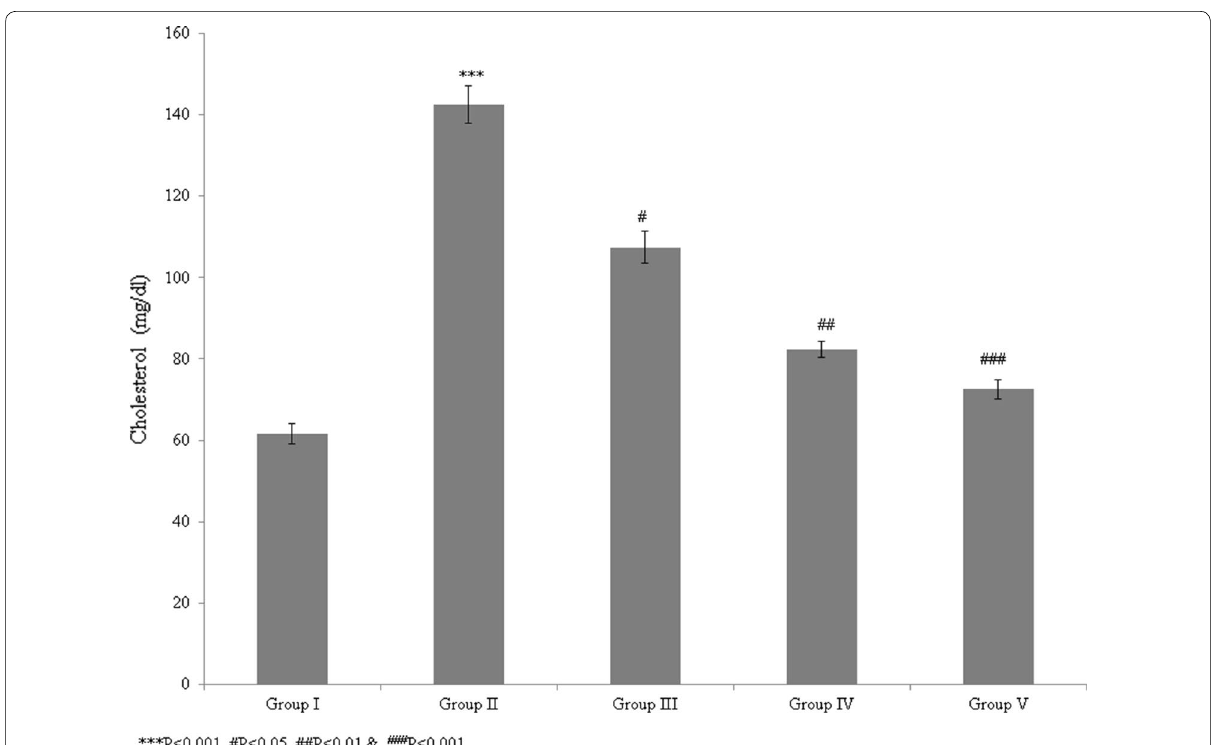
Fig. 2 The protective effect of a T. portulacastrum extract on blood cholesterol levels (mg/dL) in normal diabetic rats. *** P < 0.001 vs. sham; # P < 0.05; ## P < 0.01; ### P < 0.001 vs. control. N